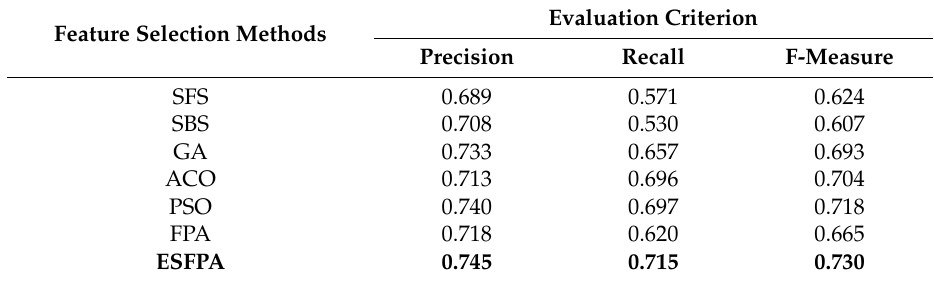
Feature Selection Methods